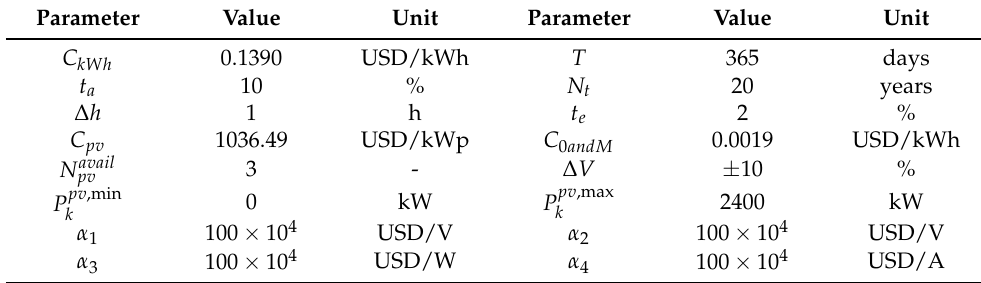
Table 1. Parameters used to calculate the objective function